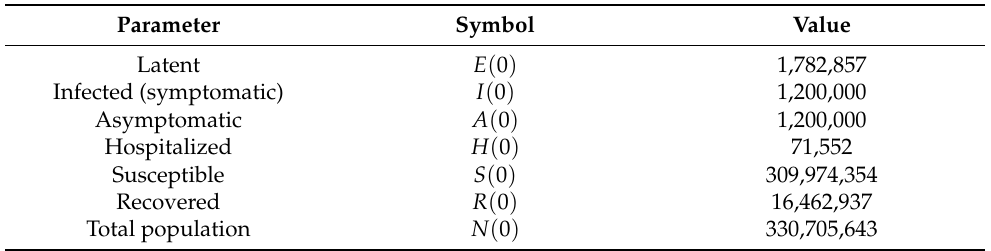
Table 1. Initial conditions assumed for the different subpopulations using the USA current situation